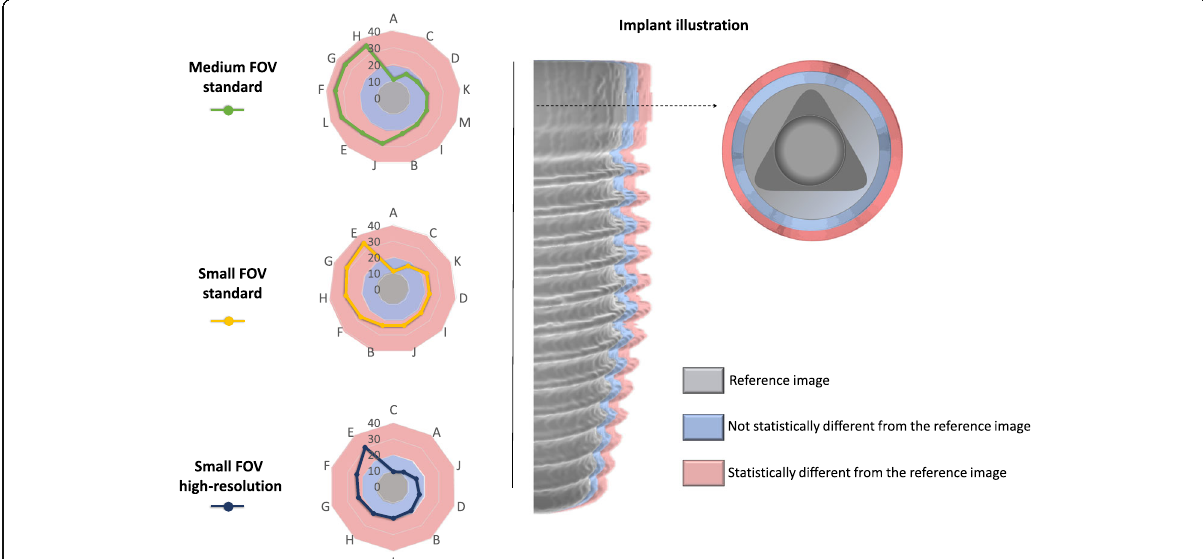
Fig. 4 Left: Radar charts of the discrepancy (in percentage) of the diameter between the reference image and each CBCT device for the three scanning protocols. Right: An illustration of an implant (grey) with non-significant (blue) and significant (pink) expressions of the blooming